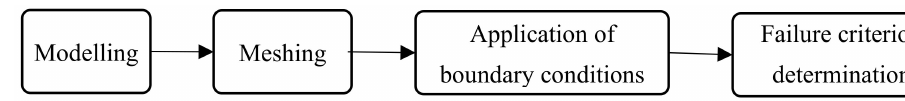
Figure 1. Flow of the development of the FEM.